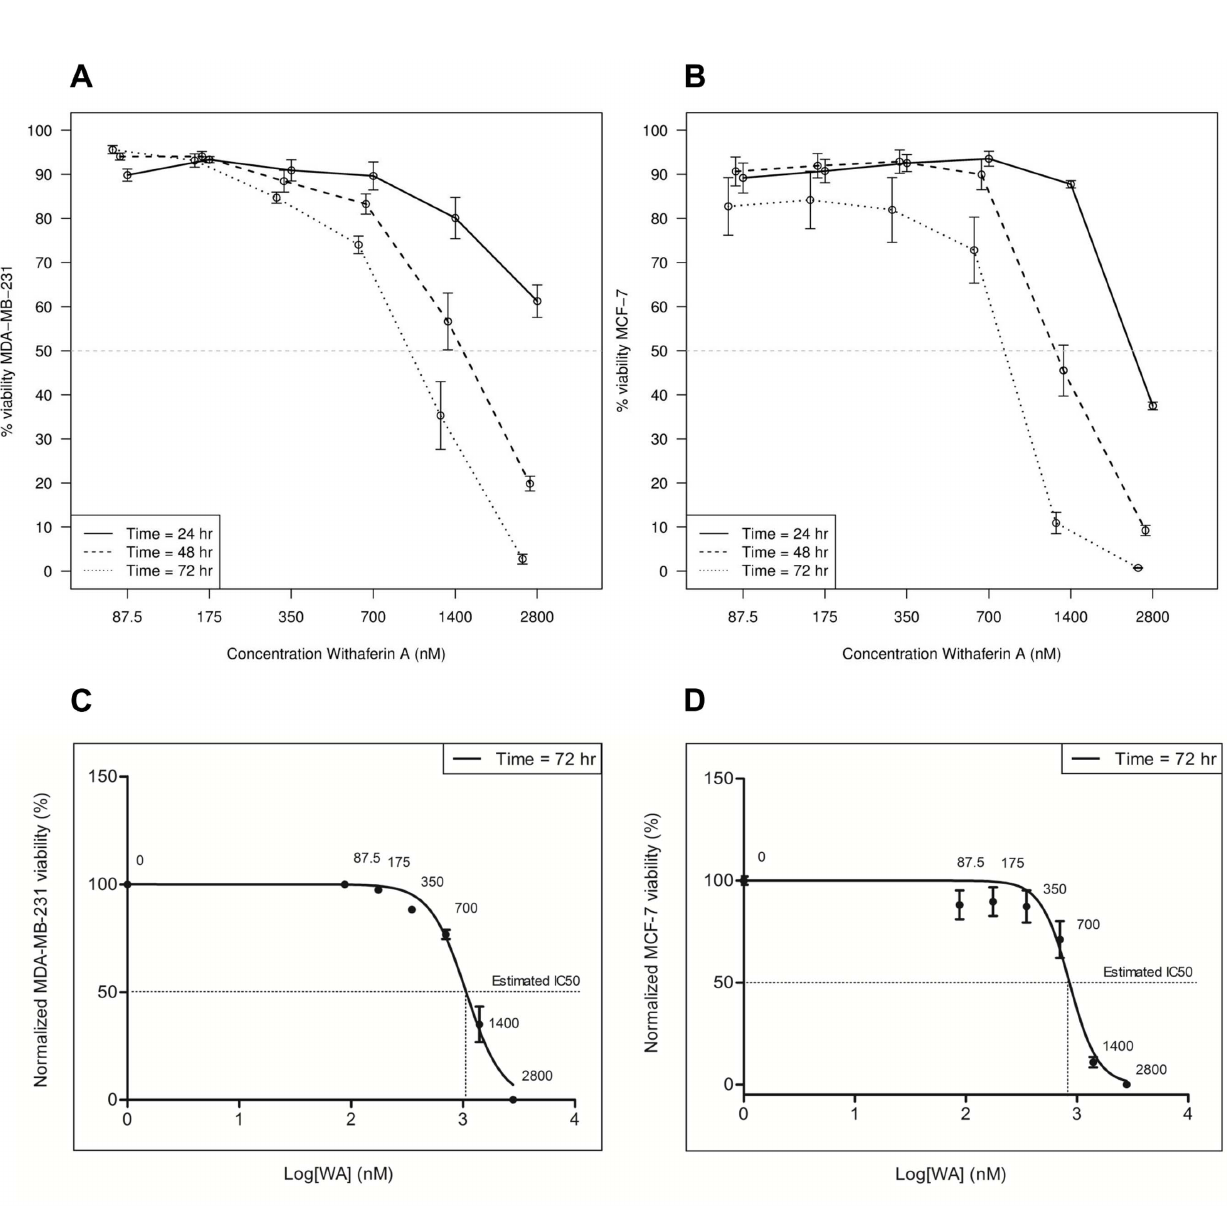
Figure 1. Effect of WA treatment on MDA-MB-231 and MCF-7 cell viability. (A – B) Dose-response curves of GelRed TM positive/negative MDA-MB-231 and MCF-7 cells treated every 24 hours with increasing concentrations of WA for a total time of 24, 48 and 72 hours as determined by FACS analysis. Data represent (mean 6 SEM) values of three independent experiments. Observed IC 50 values for each time point are marked with a dashed line. (C – D) Estimation of IC 50 values at 72 hours exposure time was performed in GraphPad Prism version 5.00 for Windows using dose- response curve fitting (log(inhibition) vs normalized response (variable slope)) of MDA-MB-231 and MCF-7 cells treated every 24 hours with different doses of WA for a total time of 72 hours. Observations were normalized to a DMSO control, here represented as 100% viability.